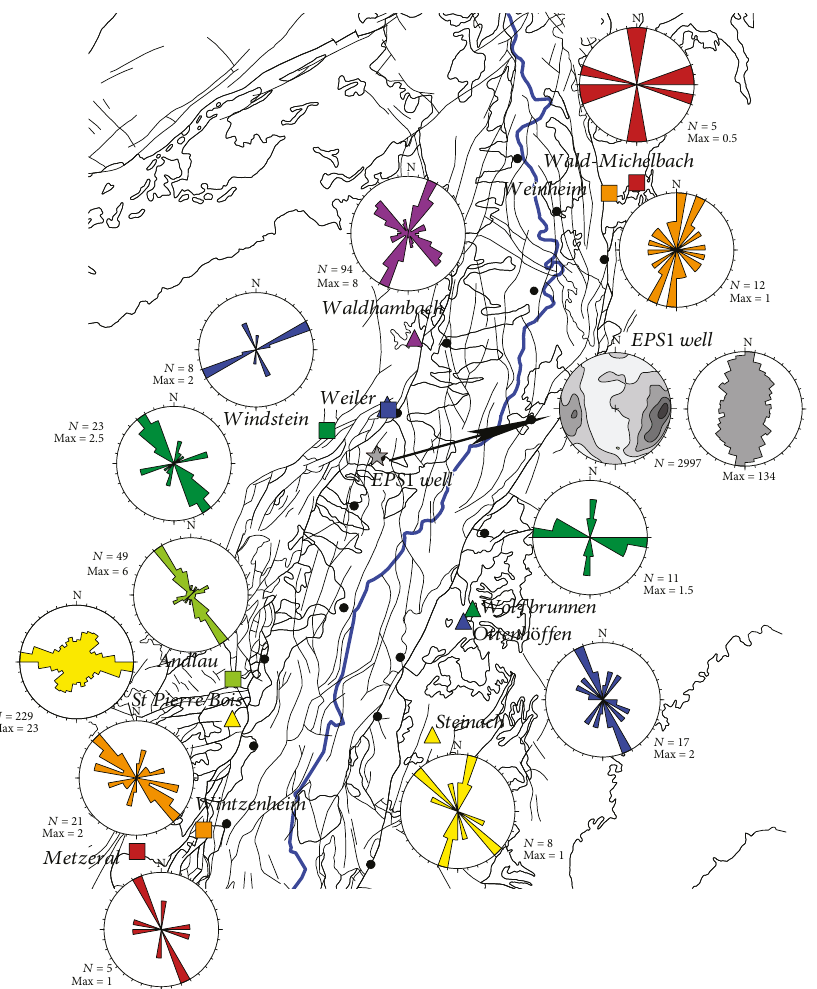
Figure 6: Fracture directions measured on Paleozoic basement outcrops including the measurements on EPS1 well cores, represented on a structural map showing major structures. Bold lines represent the main faults, and fi ne lines represent geological boundaries (same as Figure 1). For each site, the rose diagram shows the fracture direction with 10 ° classes. For EPS1 well data, contour-density diagrams in Schmidt ’ s projection, lower hemisphere: 10%, 30%, 50%, 70%, and 90% of the fracture pole maximum frequency. The di ff erent colors correspond to each site. The location of the sites is indicated by a square for outcrops, a triangle for quarries, and a star for